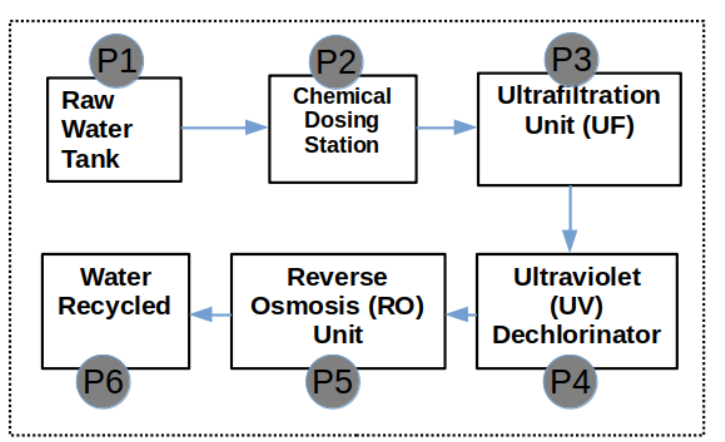
Figure 3. The water treatment plant in [11], where P1–P6 denotes total six stages of processing in the